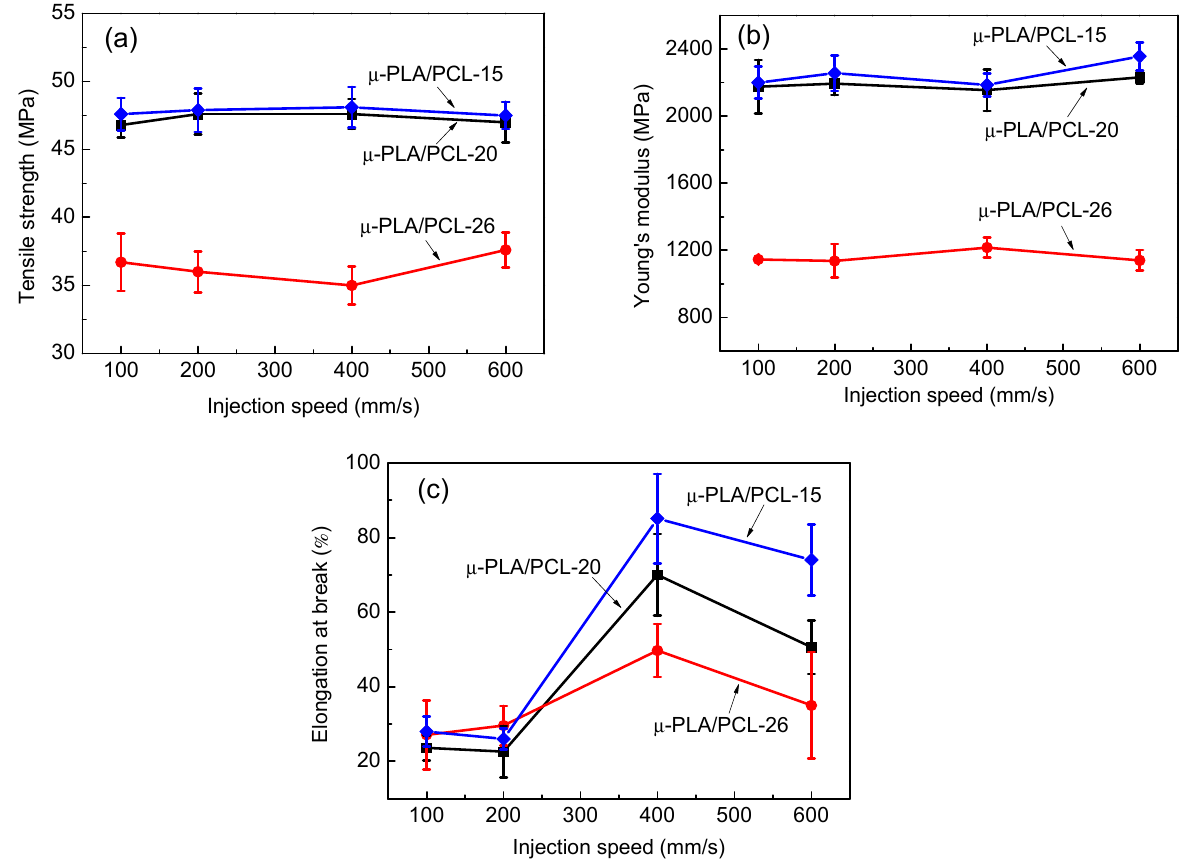
Figure 10. The mechanical properties of PLA/PCL blend microparts with different cavity size at different injection speed: tensile strength ( a ), Young’s modulus ( b ), and elongation at break ( c ).